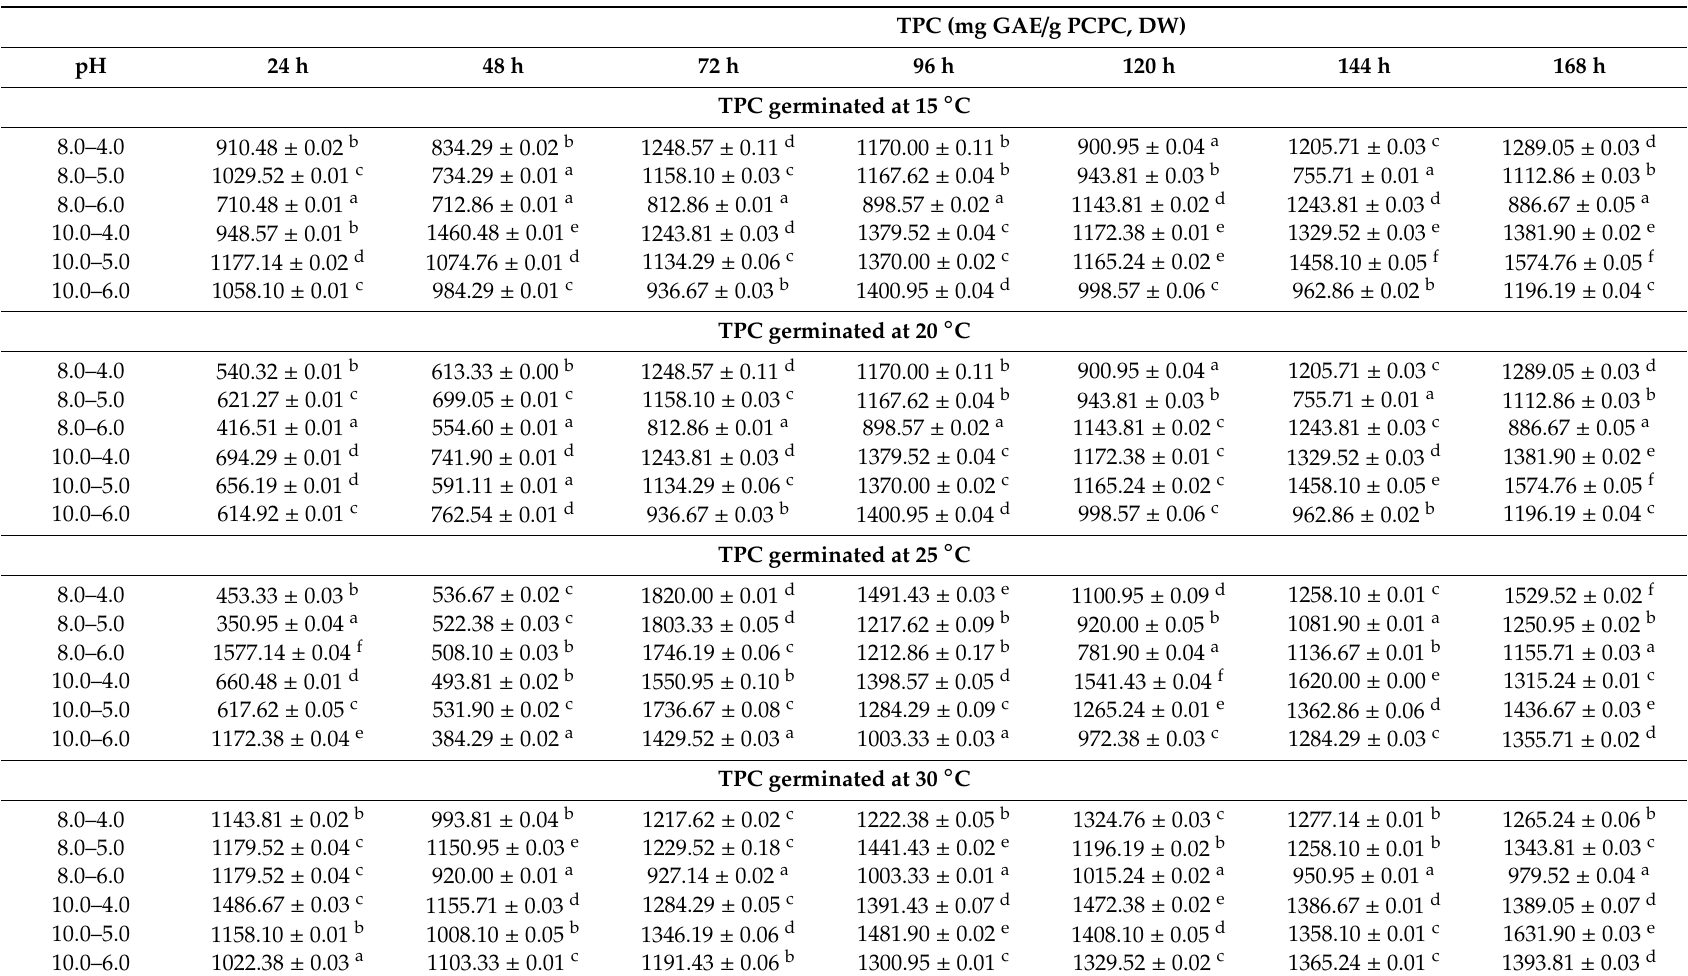
Table 3. Total phenolic content (TPC) of germinated